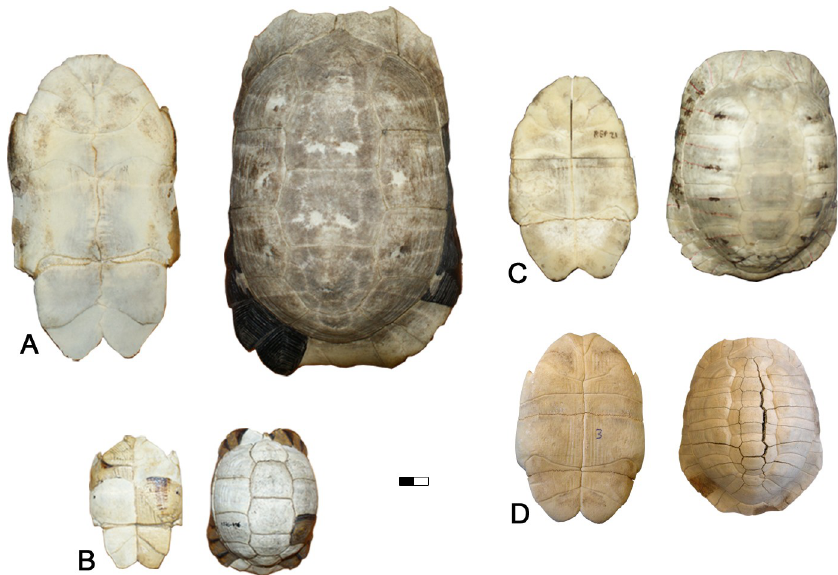
Fig 6. Modern Testudo . Carapace in ventral and dorsal views. A. T . marginata , 1877–675 MNHN. B. T . kleinmanni , 1876–416 MNHN. C. T . graeca , REP 21. D. T . hermanni , REP 7.